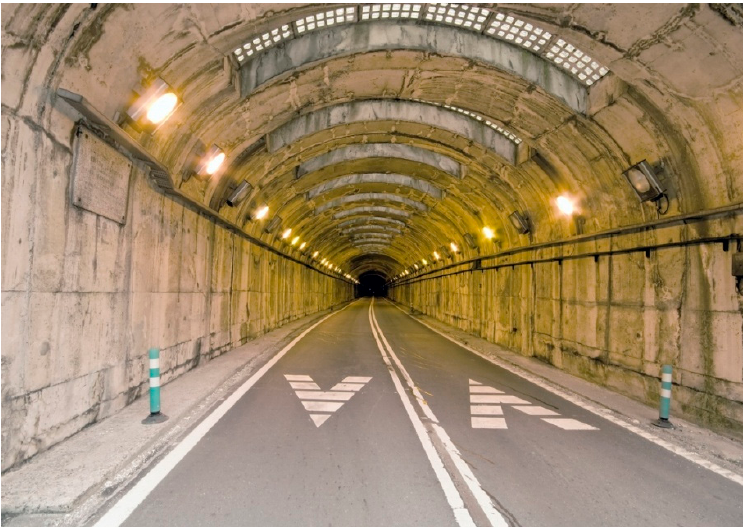
Figure 1. Upper windows to use natural light in an almost closed tunnel in Bielsa (Spain) (Image bought from [20]).